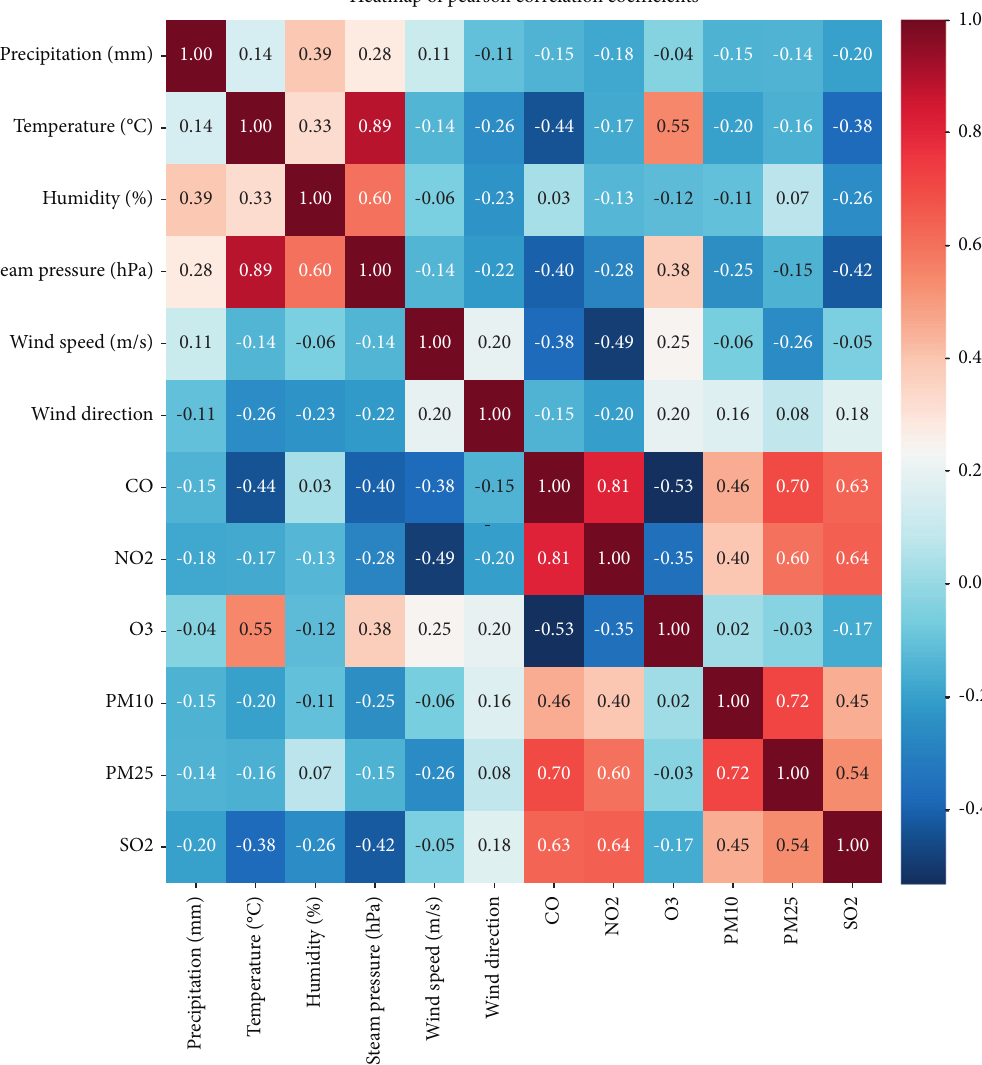
Figure 1: Heatmap showing the relations among the 27 predictor